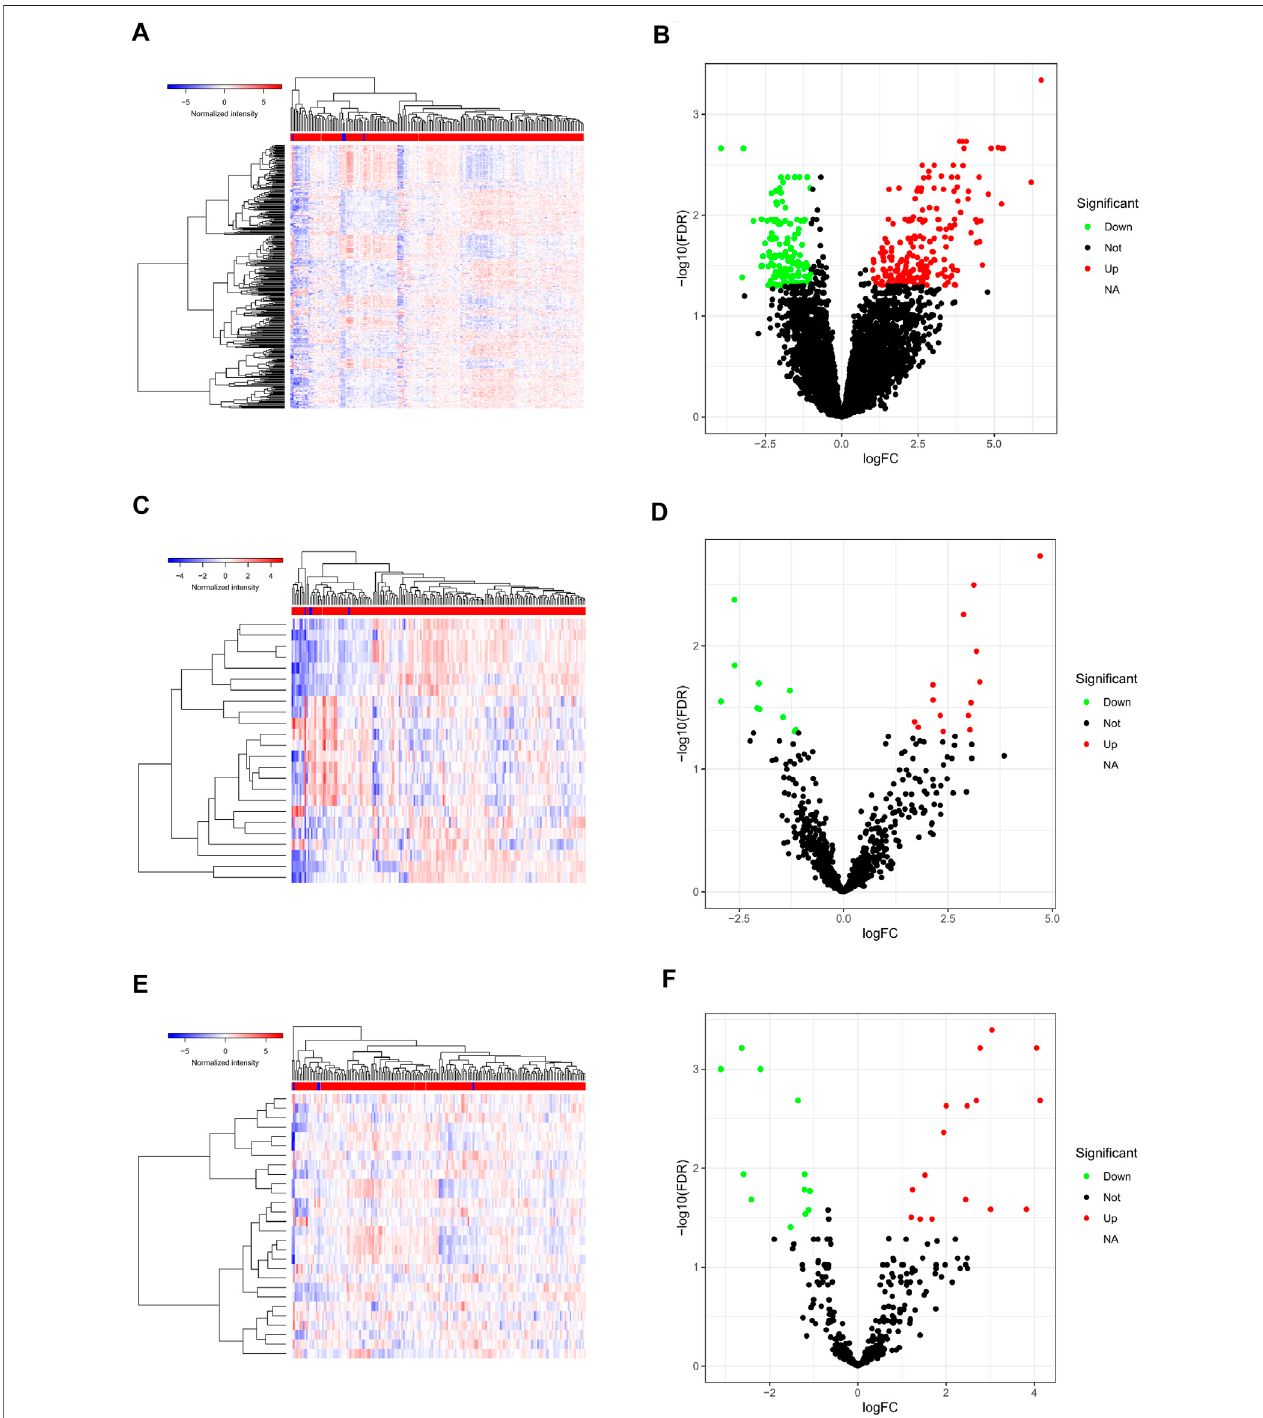
FIGURE2| DifferentiallyexpressedgenesinPAAD.Heatmap (A) andvolcanoplot (B) ofalldifferentiallyexpressed mRNAs;heatmap (C) andvolcanoplot (D) ofall differentially expressed lncRNAs; heatmap (E) and volcano plot (F) of all differentially expressed miRNAs. PAAD, pancreatic adenocarcinoma; miRNAs, microRNAs; lncRNAs, long non-coding RNAs; mRNAs, messenger RNAs.